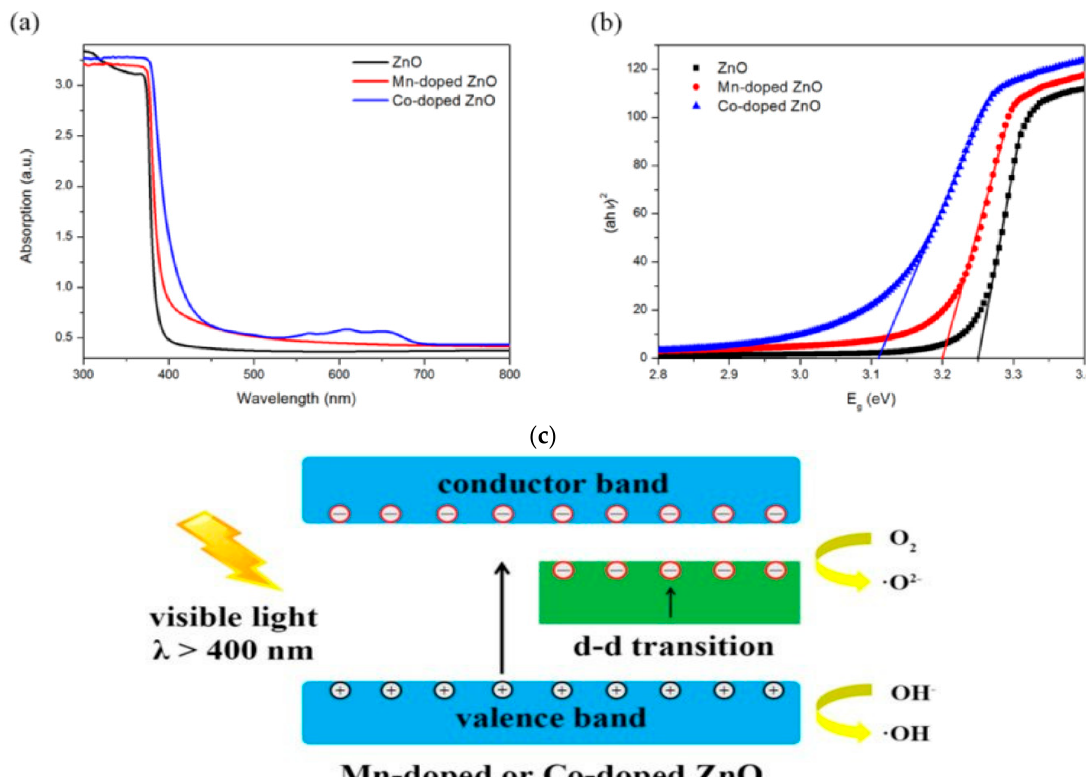
Int. J. Mol. Sci. 2020, 21, x FOR PEER REVIEW Figure 3. ( a ) UV-visible spectra of pure ZnO, Mn-doped ZnO and Co-doped ZnO nanowires, and ( b ) Tauc plots of ( α h v ) 2 versus hv for ZnO-based nanowires showing the reduction of bandgap energy through transition metal doping. ( c ) The generation of superoxide anion and hydroxyl radicals on ZnO nanowires under visible light due to the creation of midgap states in the bandgap by doping with Mn or Co. Reproduced from [108] under the terms of the Creative Commons Attribution License (CC BY).